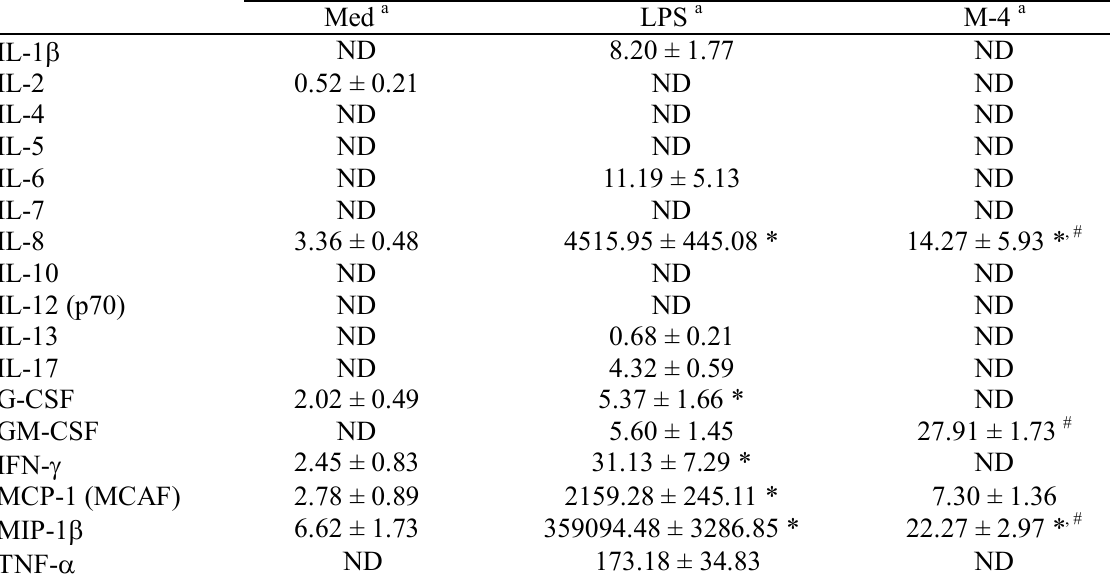
Table 1. Microparticle-based flow cytometric assay (pg/mL) of Schisandra chinensis